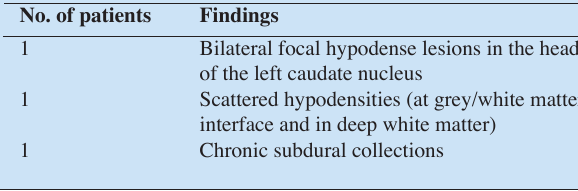
Table II. Radiological findings additional to basal ganglion calcification and